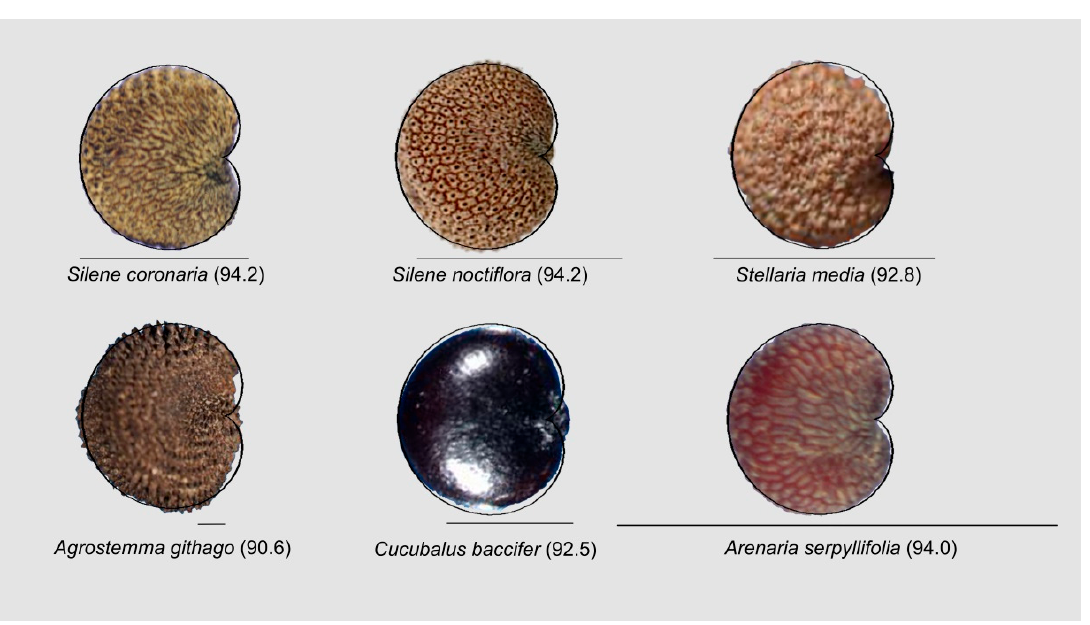
Figure 13. The cardioid is a model for seed shape description and quantification in species in the Malvaceae. All the species represented are herbs, except Abutilon, which is a sub-shrub. The values indicated correspond to J index in the images shown and do not mean values for each particular species. Bar equals 0.5 mm.